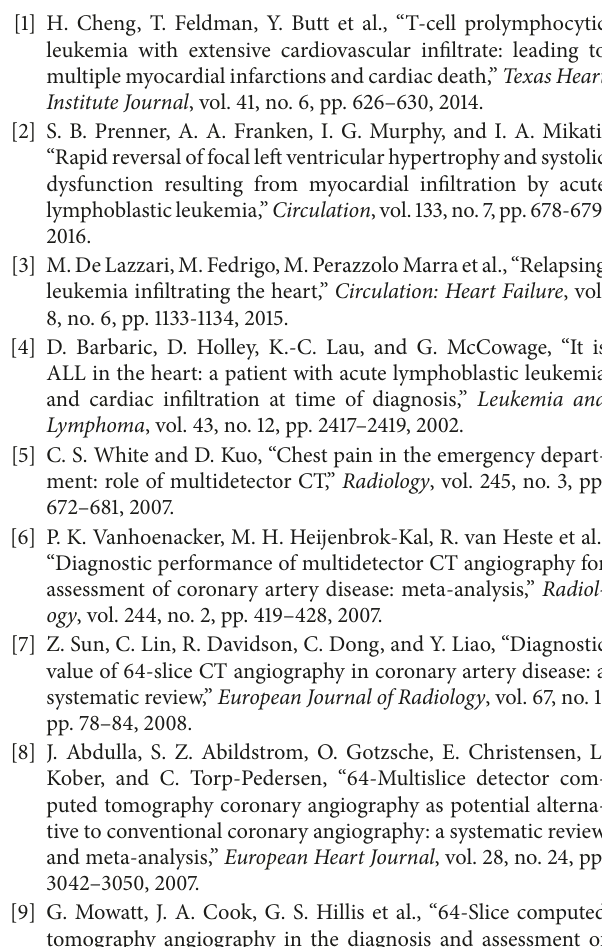
with a large leukemic right ventricular mass incidentally detected on routine pretreatment echocardiogram [4].